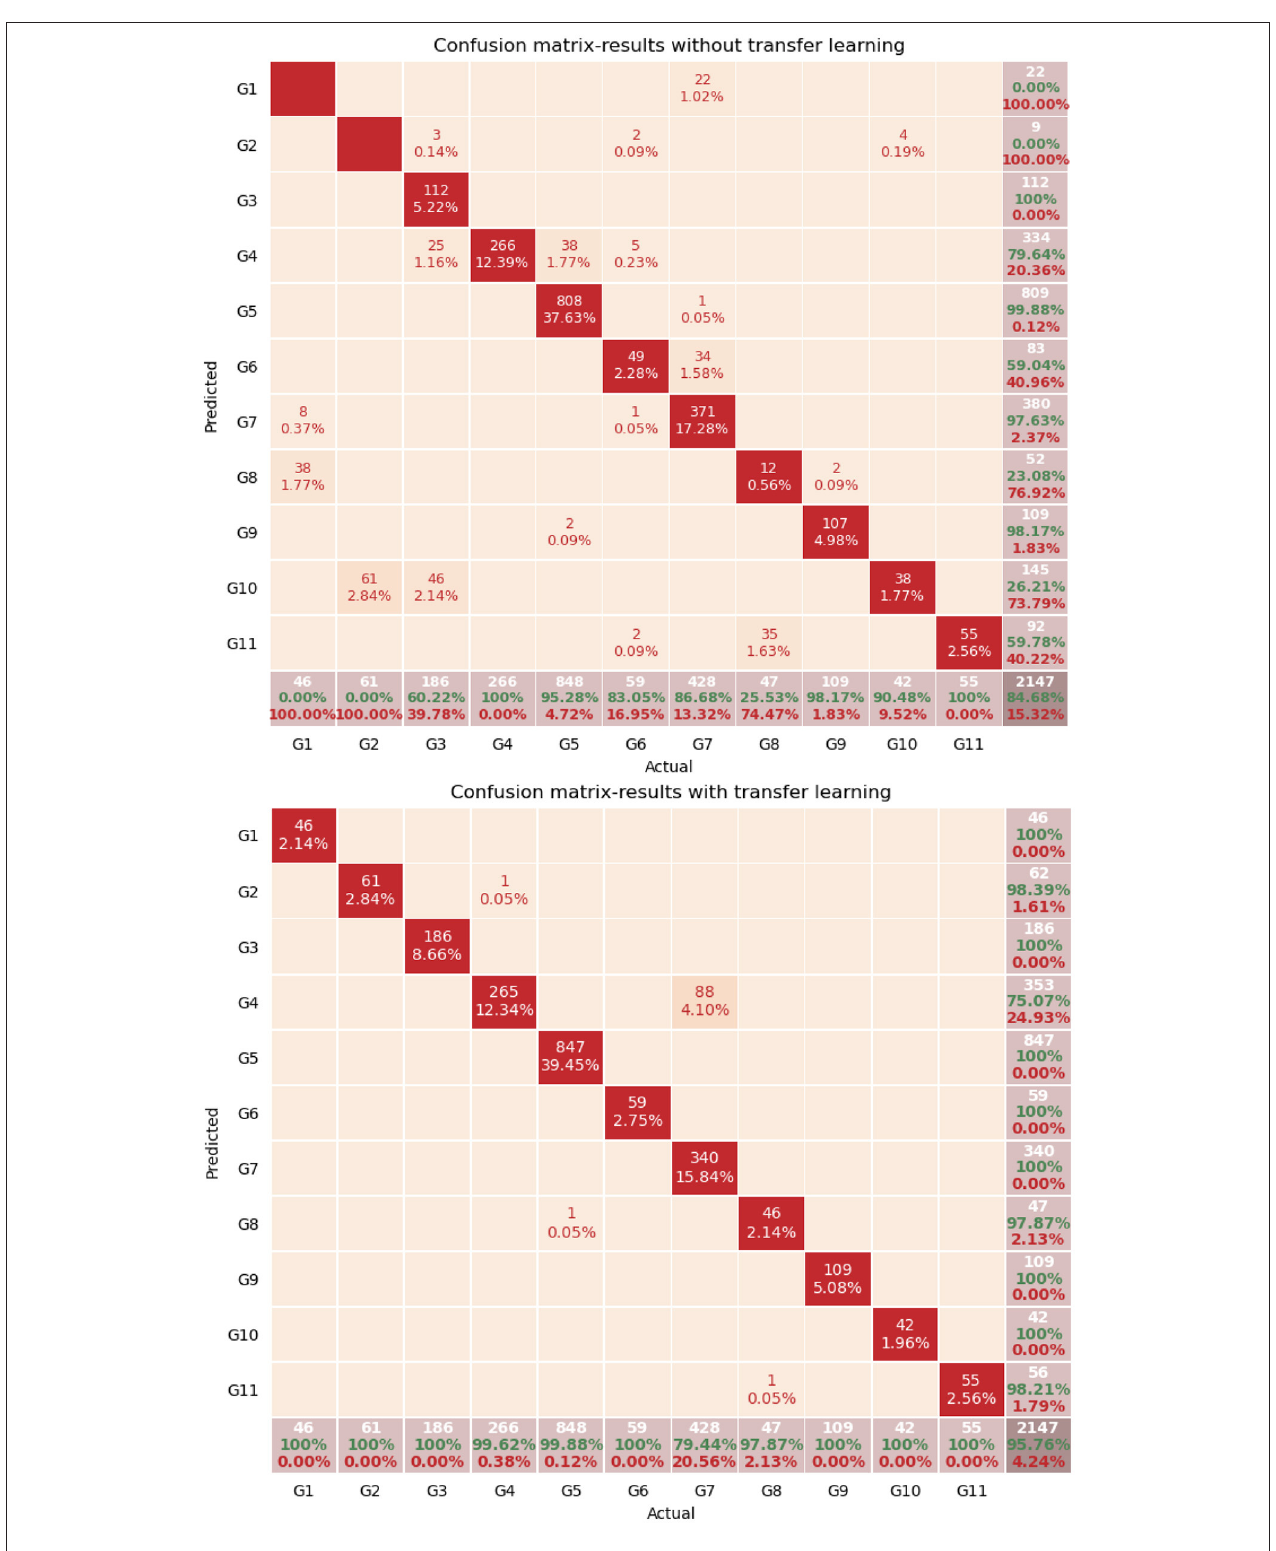
FIGURE 8 | Confusion matrices with only new users in the test set. Without transfer learning (top) and with transfer learning (bottom) .